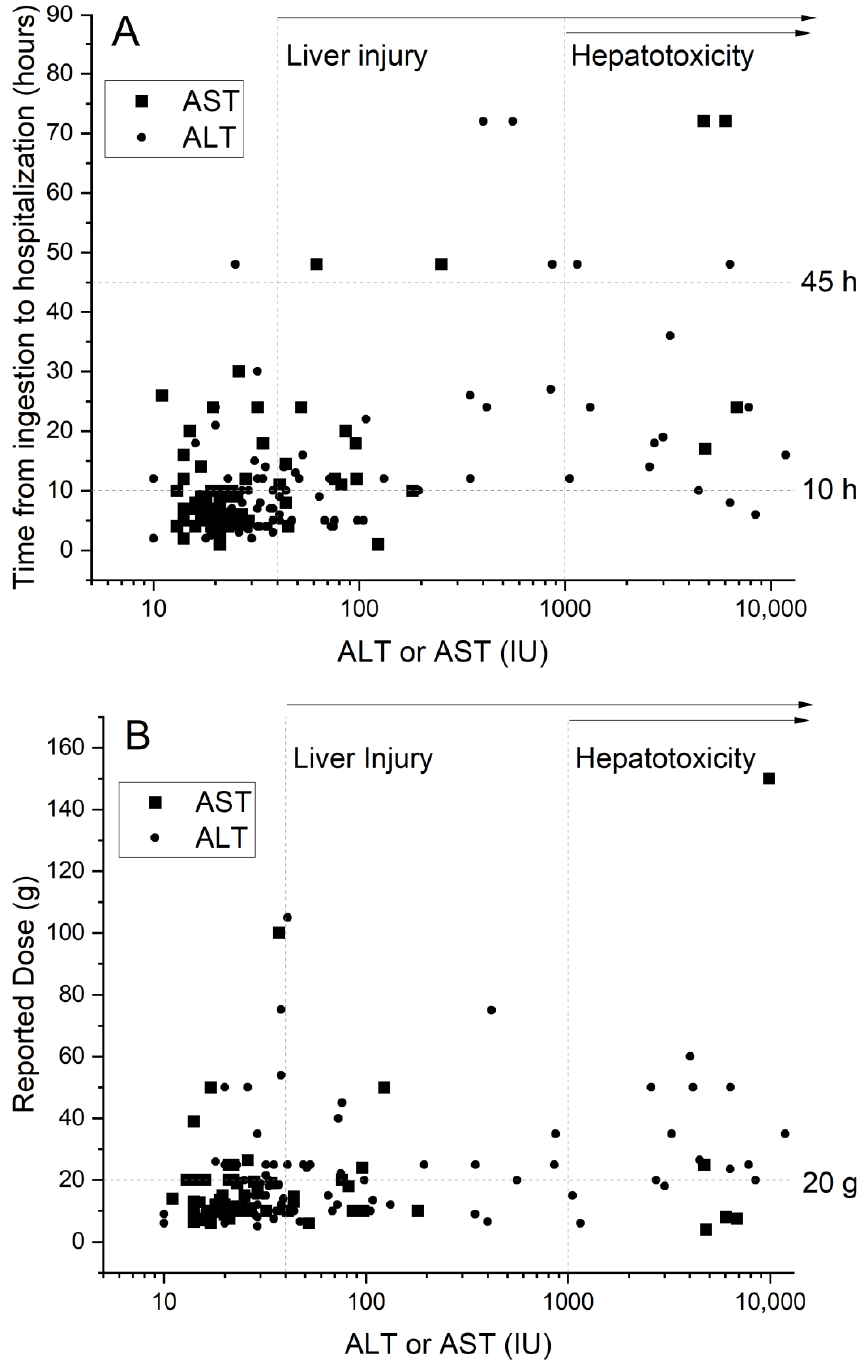
Figure 2. The relationship between the asparagine aminotransferase (AST) or / the alanine aminotransferase (ALT) levels and time from paracetamol ingestion to hospitalization ( A ). The relationship between AST / ALT and the reported paracetamol dose ( B ). Squares and circles represent AST and ALT values, respectively. The higher value among ALT and AST is displayed. The values on X axes are presented on a log 10 scale.